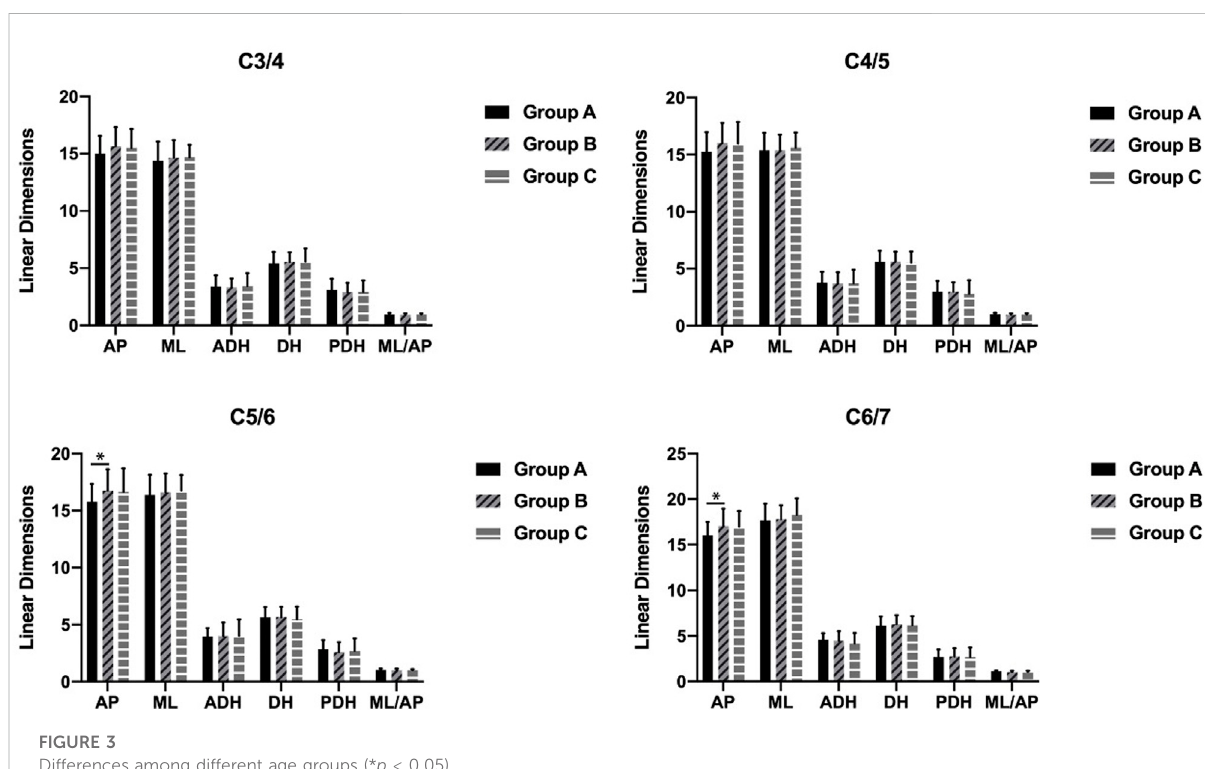
FIGURE 3 Differences among different age groups (* p < 0.05).